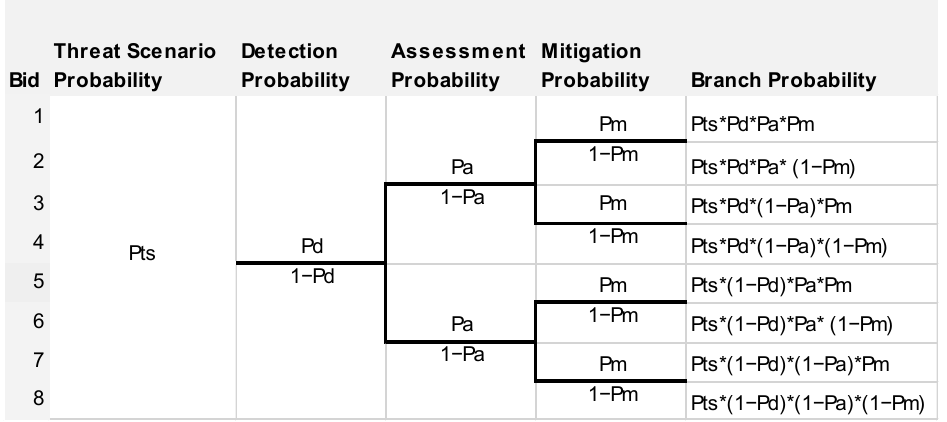
Figure 4. Quantitative view of the even tree for the assessment of threat scenarios related to drone intrusions in airports.